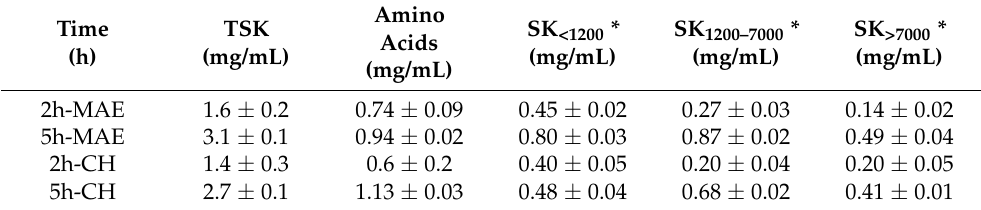
Scheme 1. Scheme of the procedure employed for the full characterization of the extraction products. REK = raw extracted keratin; NSK = not soluble keratin; TSK = total soluble keratin; SK >7000 = soluble keratin molecules with molecular weight > 7000 Da; SK >1200 = soluble keratin molecules with molecular weight > 1200 Da; SK IP = purify keratin by isoelectric precipitation; SK <3000 = soluble keratin molecules with molecular weight < 3000 Da. Table 2. TSK, amino acids, SK <1200 , SK 1200 − 1700 and SK >7000 concentration expressed in mg/mL, obtained in the various experimental conditions explored (75:1 solvent/feather ratio). The results are expressed as average ± standard deviation ( N = 3 replicates).